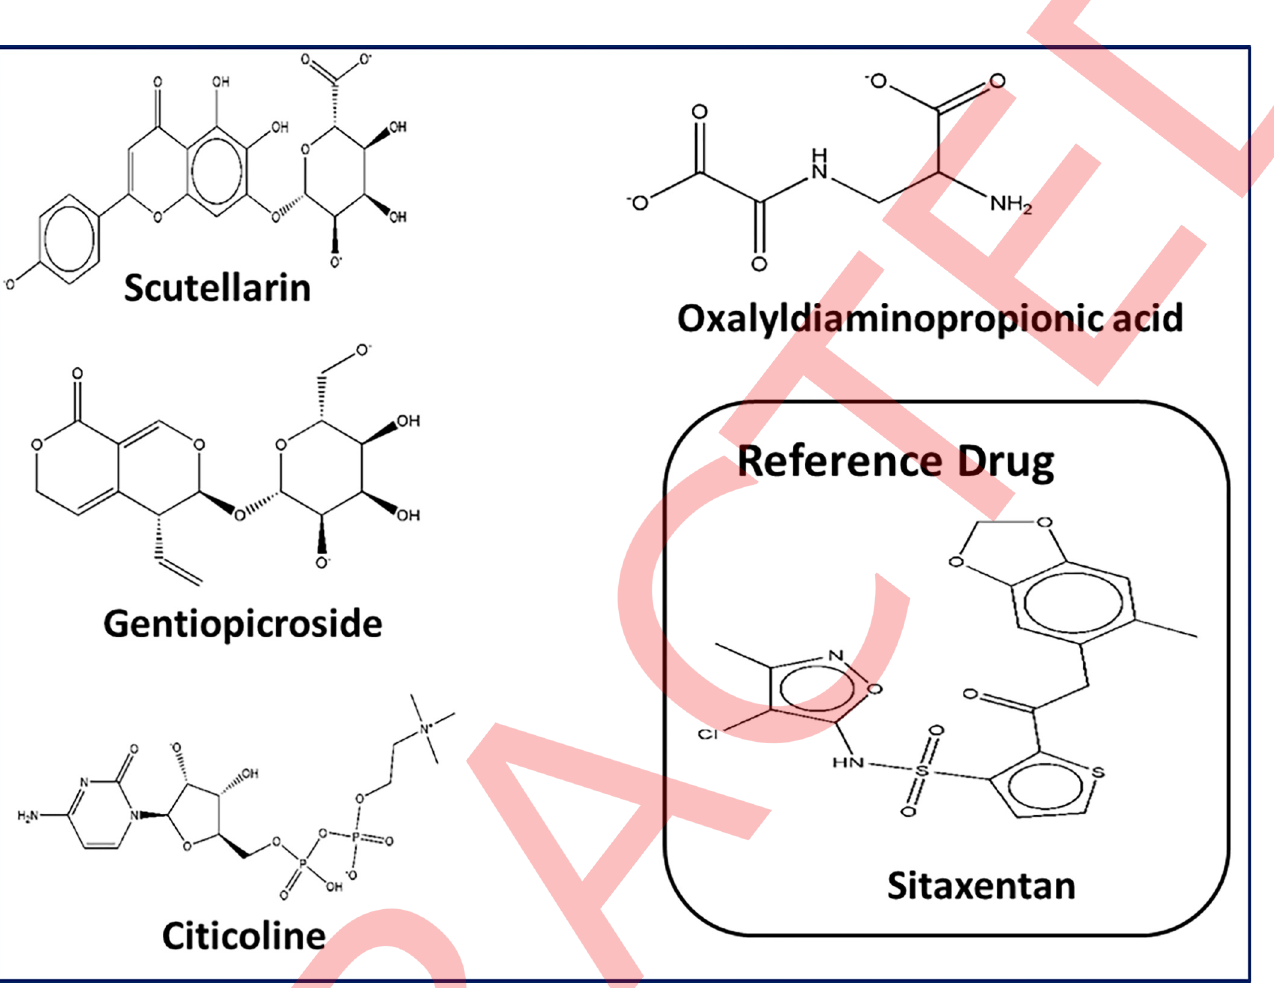
Fig 1. 2D structures of top four selected phytochemicals along with the reference drug.